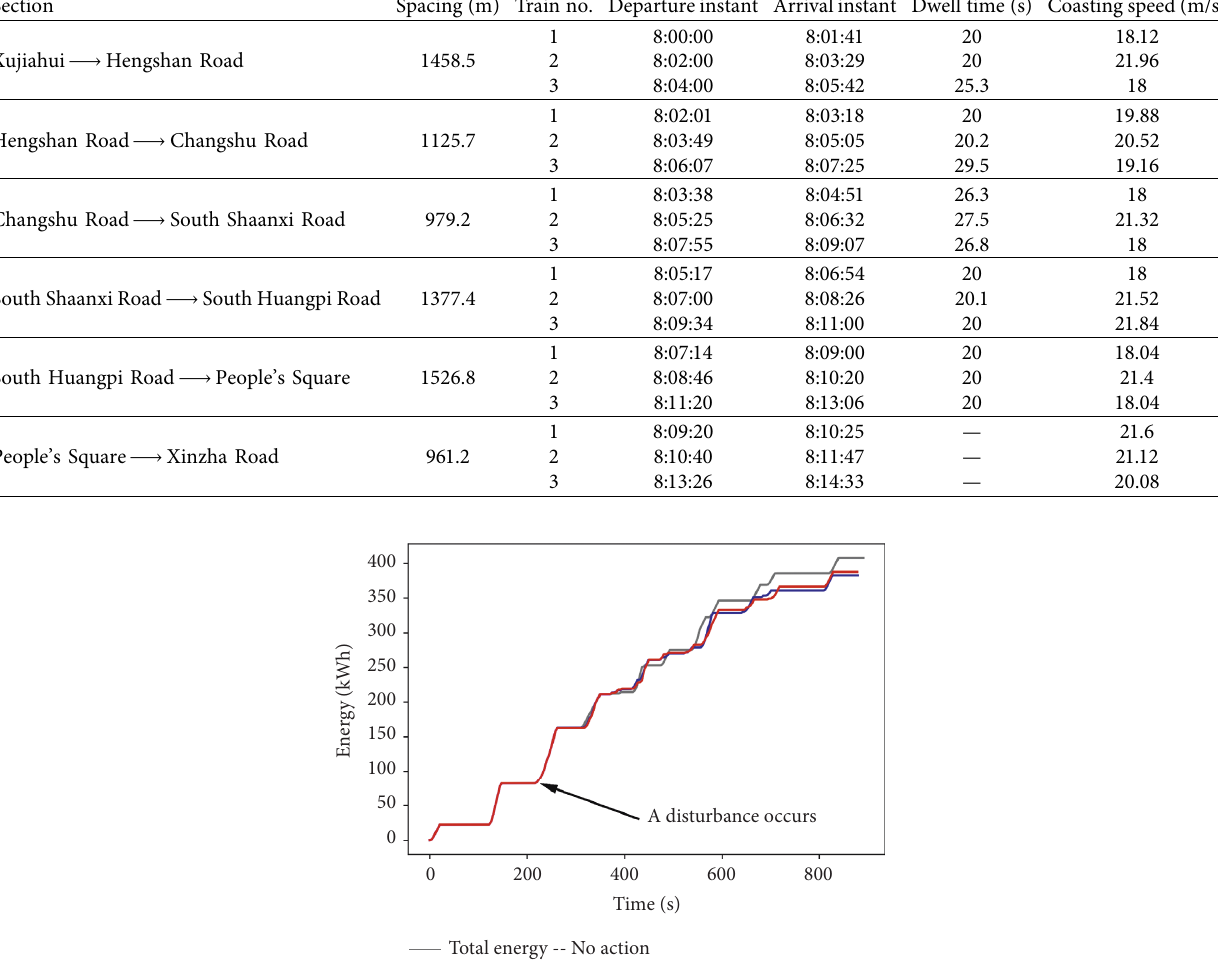
Table 6: The optimal timetable of the three-train system.